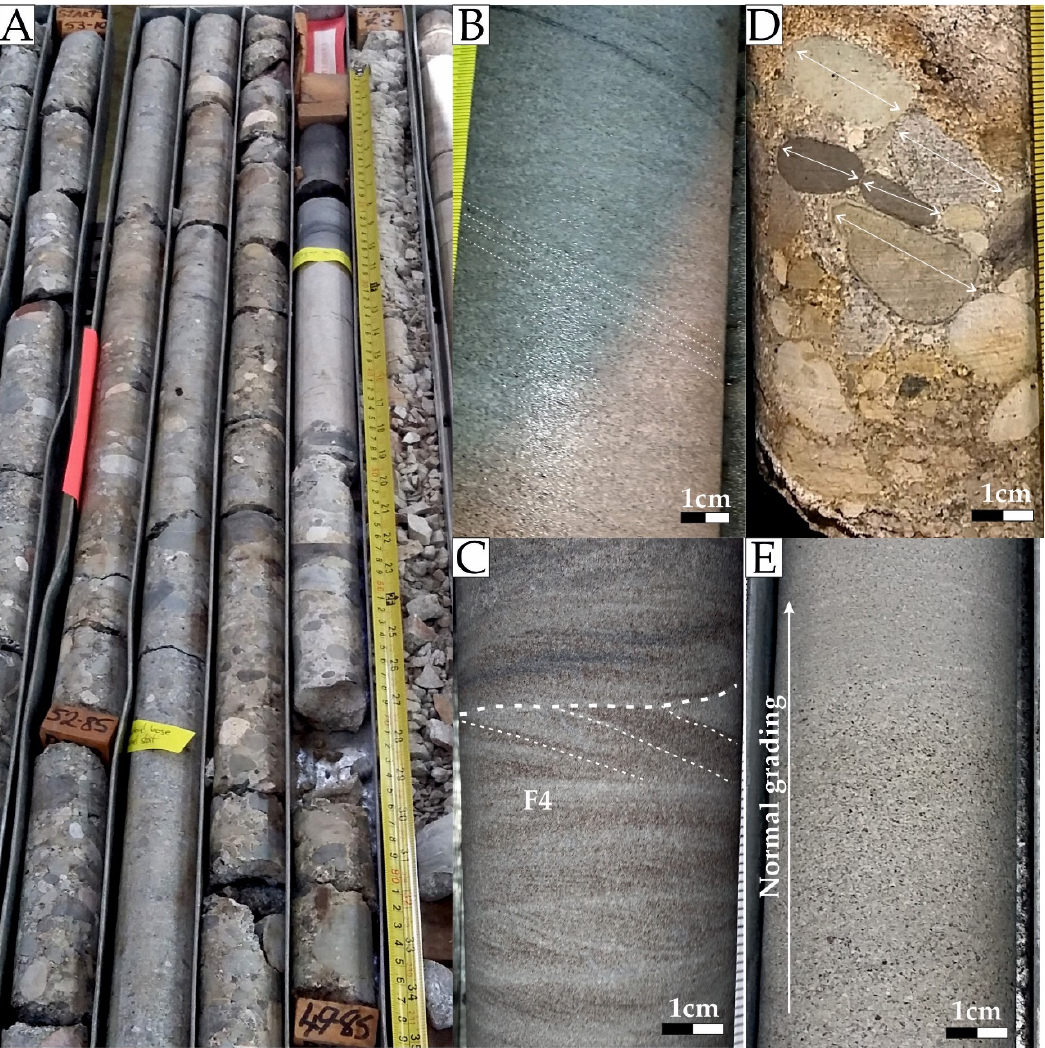
Figure 3. Core photographs illustrating sedimentological characteristics of the FA1 (fluvial channels). ( A ) Clast to matrix- supported conglomerate, followed by structureless sandstone. Note the upward decrease in the grain-size that reflects the progressive reduction of the river strength and migration of the fluvial channels. ( B ) Planar cross-bedded sandstone. Note that the cross-beds are sometimes filled with mudstone. ( C ) Co-sets of trough-cross-laminated sandstone separated by low angle bounding surfaces. ( D ) Clast-supported conglomerate exhibiting clast imbrication. ( E ) Normally-graded sandstone.